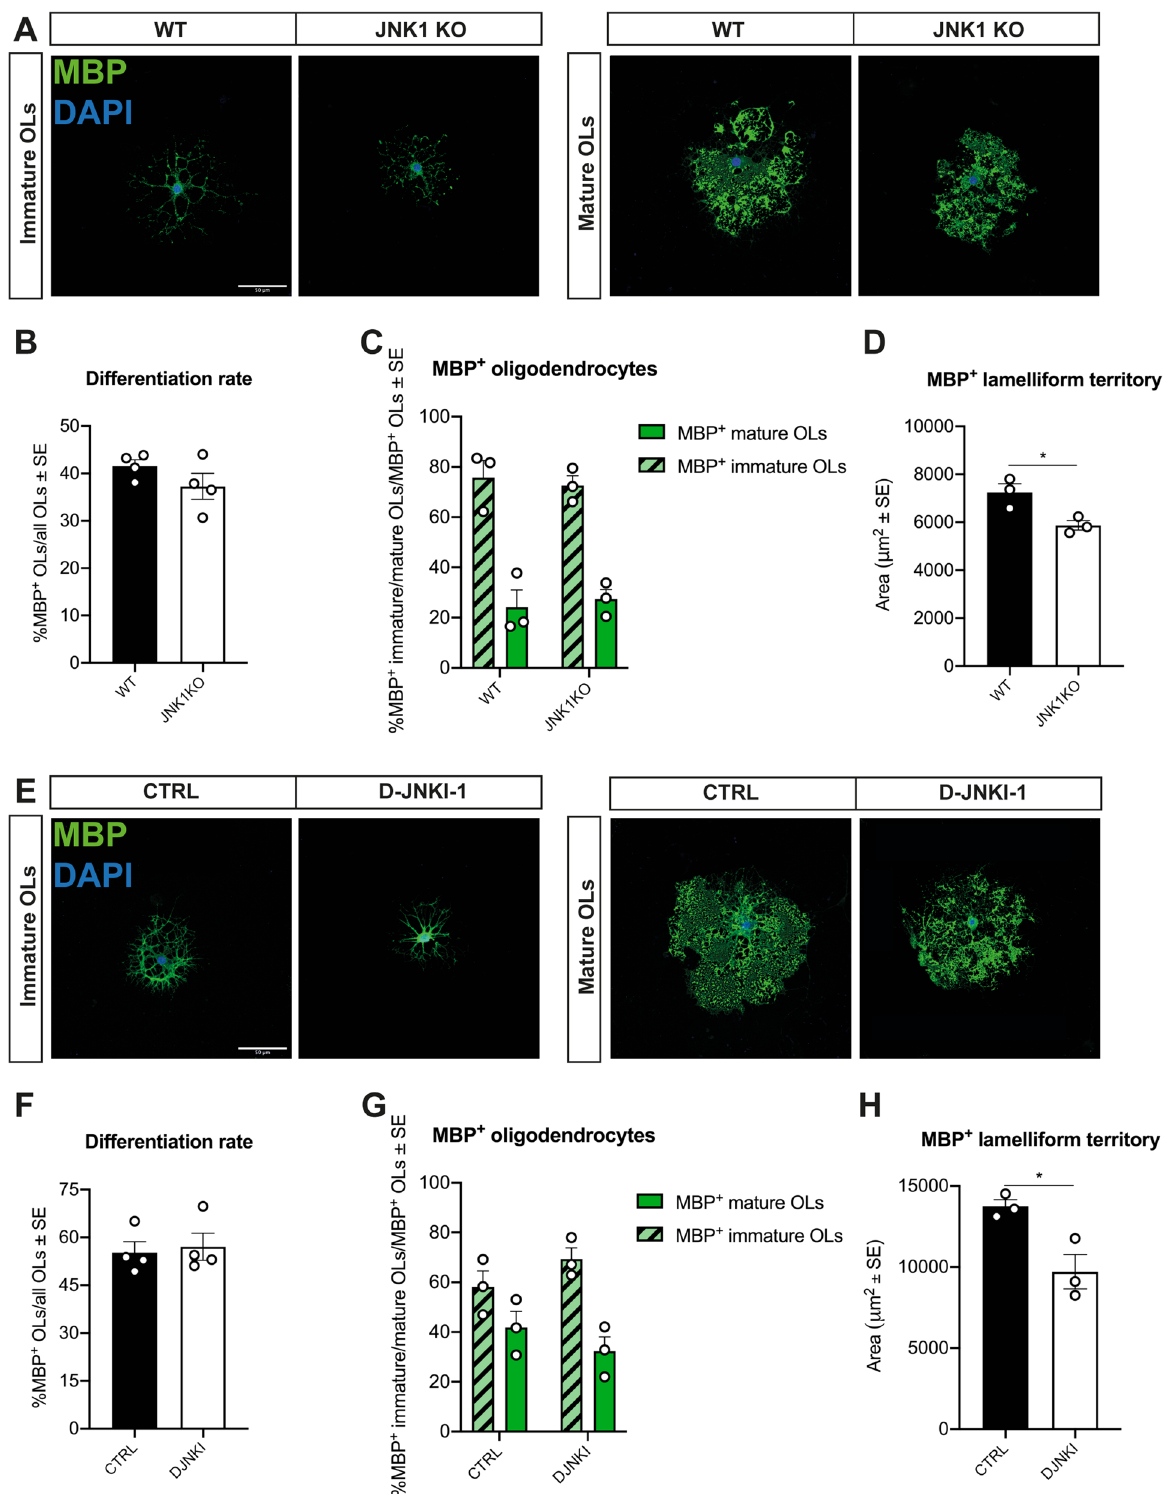
Figure 6. JNK1 KO and D-JNKI-1 treated OLs can differentiate and produce MBP . ( A ) Representative images and ( B ) quantification of differentiated MBP + WT vs JNK1 KO OLs (green). DAPI (blue) counterstains cell nuclei. ( C ) Quantification of the percentage of immature and mature WT vs JNK1 KO OLs. ( D ) Quantification of the MBP + lamelliform territory occupied by WT vs JNK1 KO OLs. ( E ) Representative images and ( F ) quantification of differentiated MBP + CTRL vs D-JNKI-1 treated OLs (green). DAPI (blue) counterstains cell nuclei. ( G ) Quantification of the percentage of immature and mature CTRL vs D-JNKI-1 treated OLs. ( H ) Quantification of the MBP + lamelliform territory occupied by CTRL vs D-JNKI-1 treated OLs. Scale bars: 50 μm in (A) and (E). WT wild type, MBP Myelin Basic Protein, CTRL control cells, D-JNKI-1 JNK1 inhibitor-treated cells. *P <